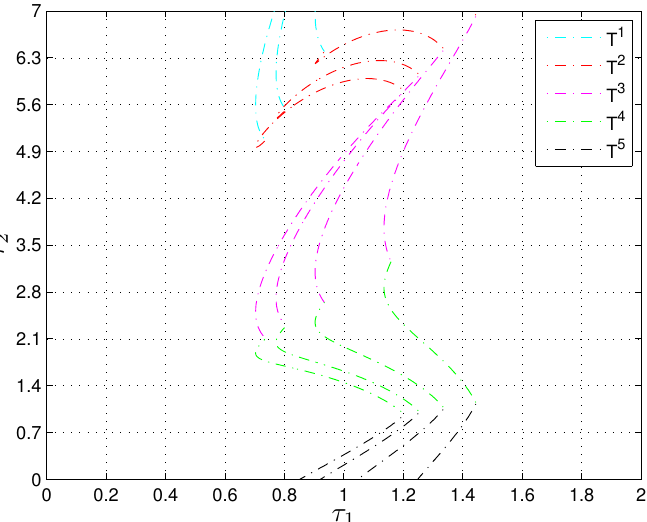
Figure 7. Stability crossing curves for different η . From the left to the right are the stability crossing curves of η = 0.6, η = 0.7, η = 0.8, and η =